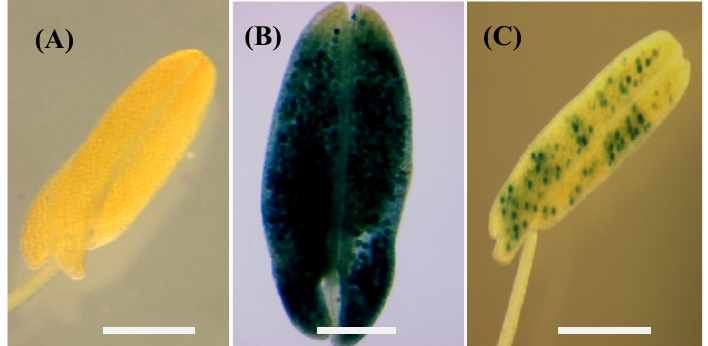
Figure 8. GUS activity in mature anthers from T non-transgenic negative control; ( B ) pOsUbiPro::GUS T throughout all anther tissues and pollen; ( C ) p Zm13 Pro::GUS T GUS activity. Scale bars = 0.3